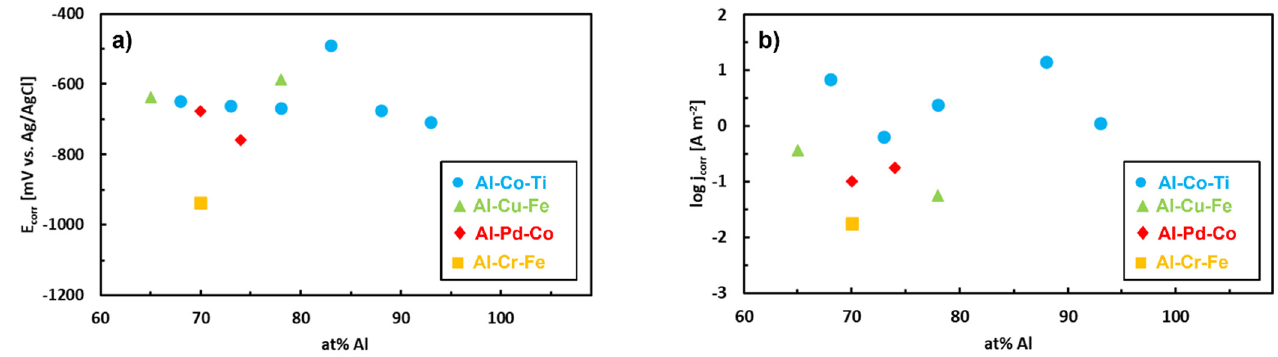
Figure 20. Corrosion parameters of ternary Al–TM alloys in aqueous NaCl (0.6 mol L − 1 ). Data is compiled from references [90,107,109,110].